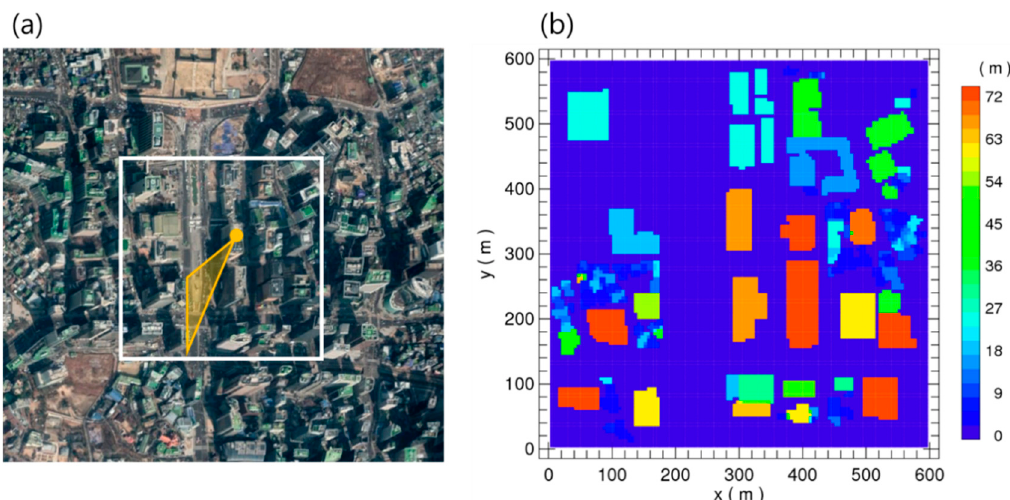
Figure 4. ( a ) The aerial photograph of a highly built-up urban area (“Gwangwhamoon”) in Seoul, South Korea and ( b ) the spatial distribution of the buildings represented for the CFD simulation. The rectangle area in ( a ) represents the CFD simulation domain and the solid circle denotes the location of the meteorological tower. The triangular area denotes the view angle of the infrared thermal imagery camera deployed at the rooftop of the building.